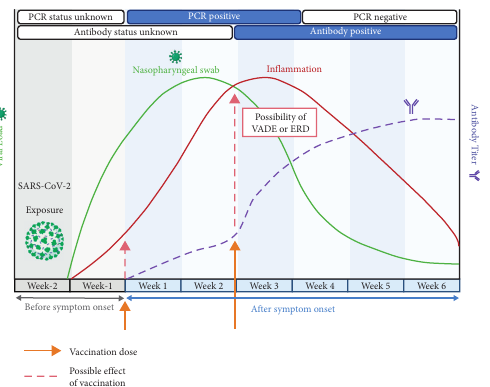
Figure 3: A schematic timeline of events showing SARS-CoV-2 exposure, PCR status, vaccine administration, the development of symptoms, inflammation, and the possibility of vaccine-associated disease enhancement (VADE) and enhanced respiratory disease (ERD). Upon the exposure to SARS-CoV-2, inflammation (red line) can occur until the symptom onset. During this period, the inflammation response can be amplified by the presence of VADE or ERD (pink arrow) when the patient had already been exposed to vaccinations (orange